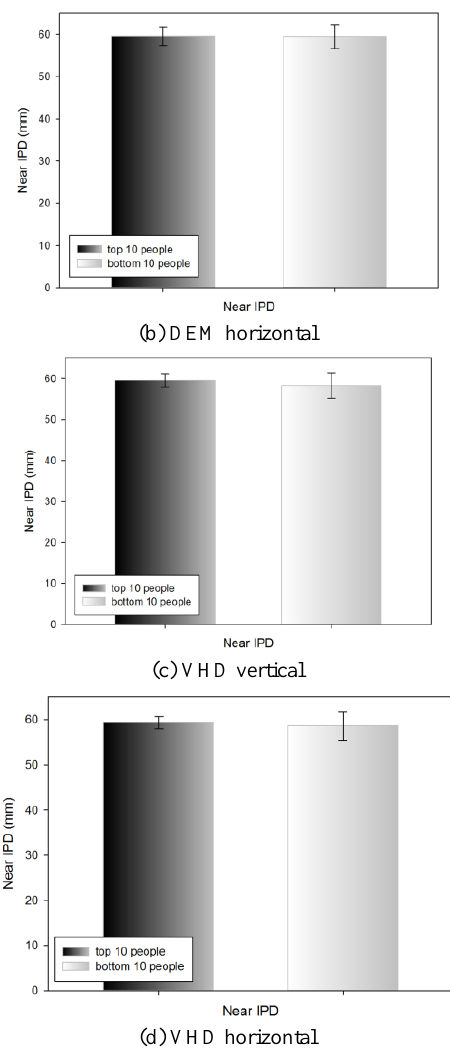
Figure 11. Near IPD of the top 10 and bottom 10 people in the DEM and VHD tests (*: